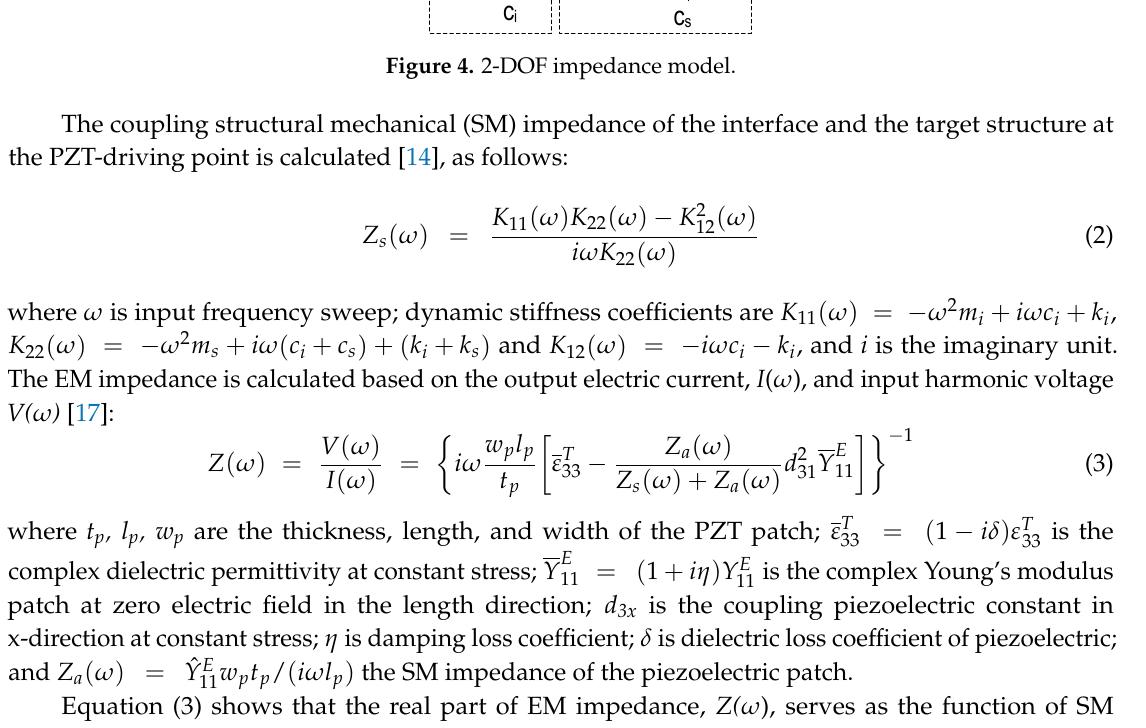
is the complex Young’s modulus patch at zero